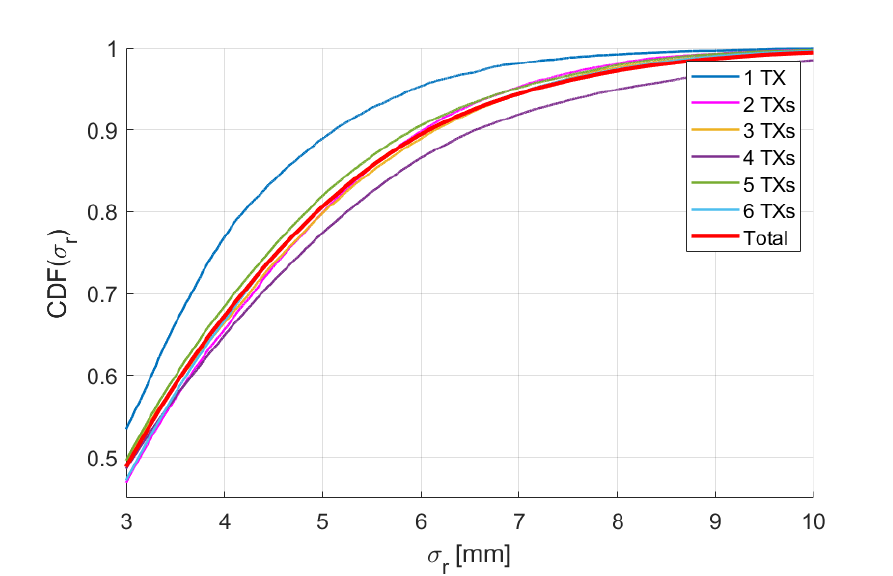
Figure 13. Cumulative distribution functions of σ r .